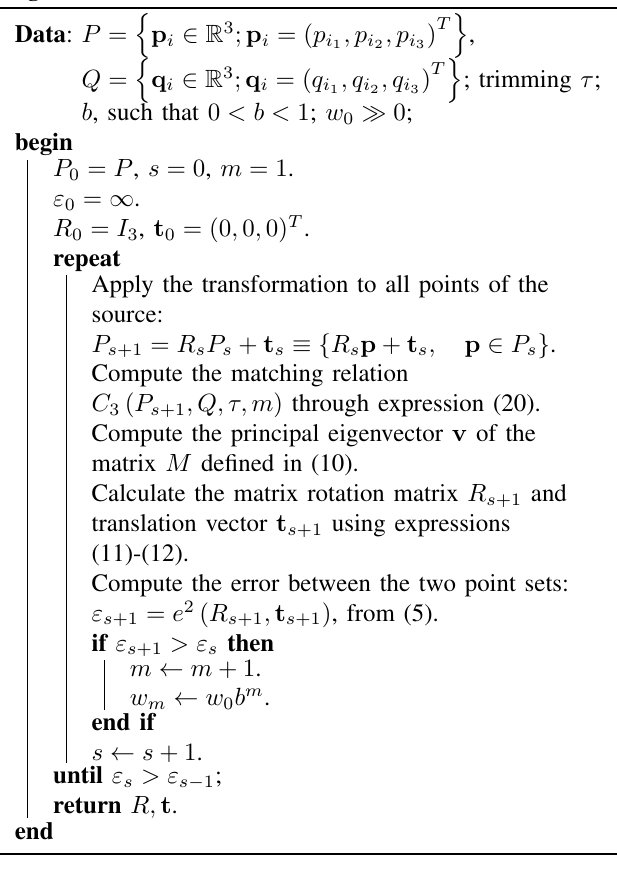
Algorithm 2: ICP-CTSF